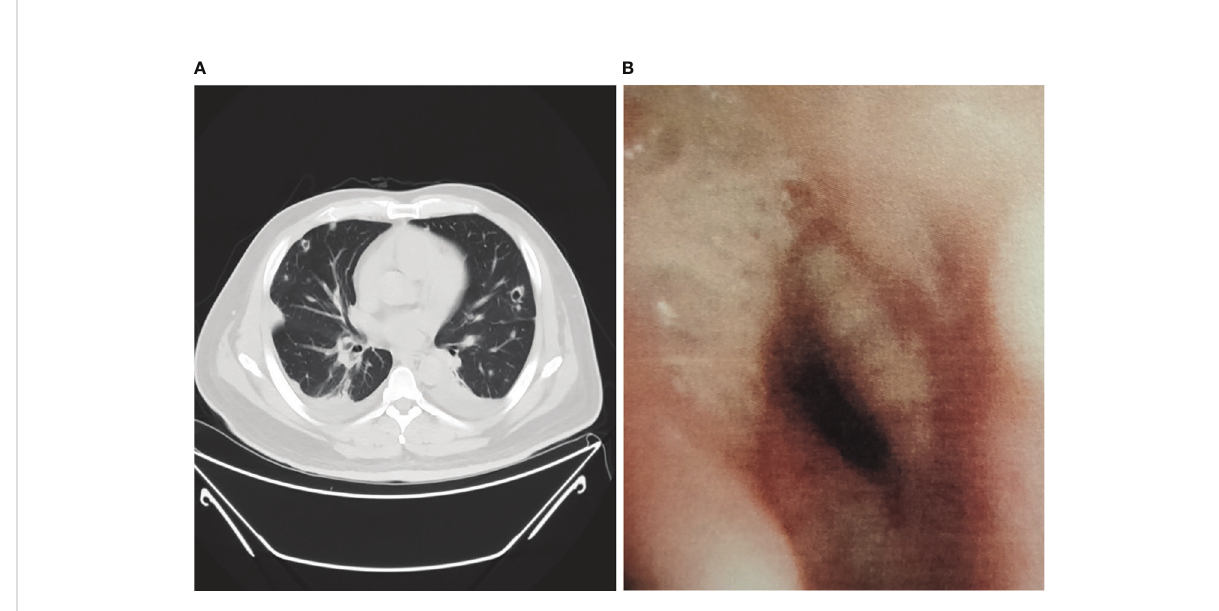
FIGURE 1 Chest CT scan and bronchoscopy of pulmonary aspergillosis in non-neutropenic patient. (A) Chest CT showed cavitation signs; (B) Bronchoscopy showed purulent secretions, mucosal hyperemia, and